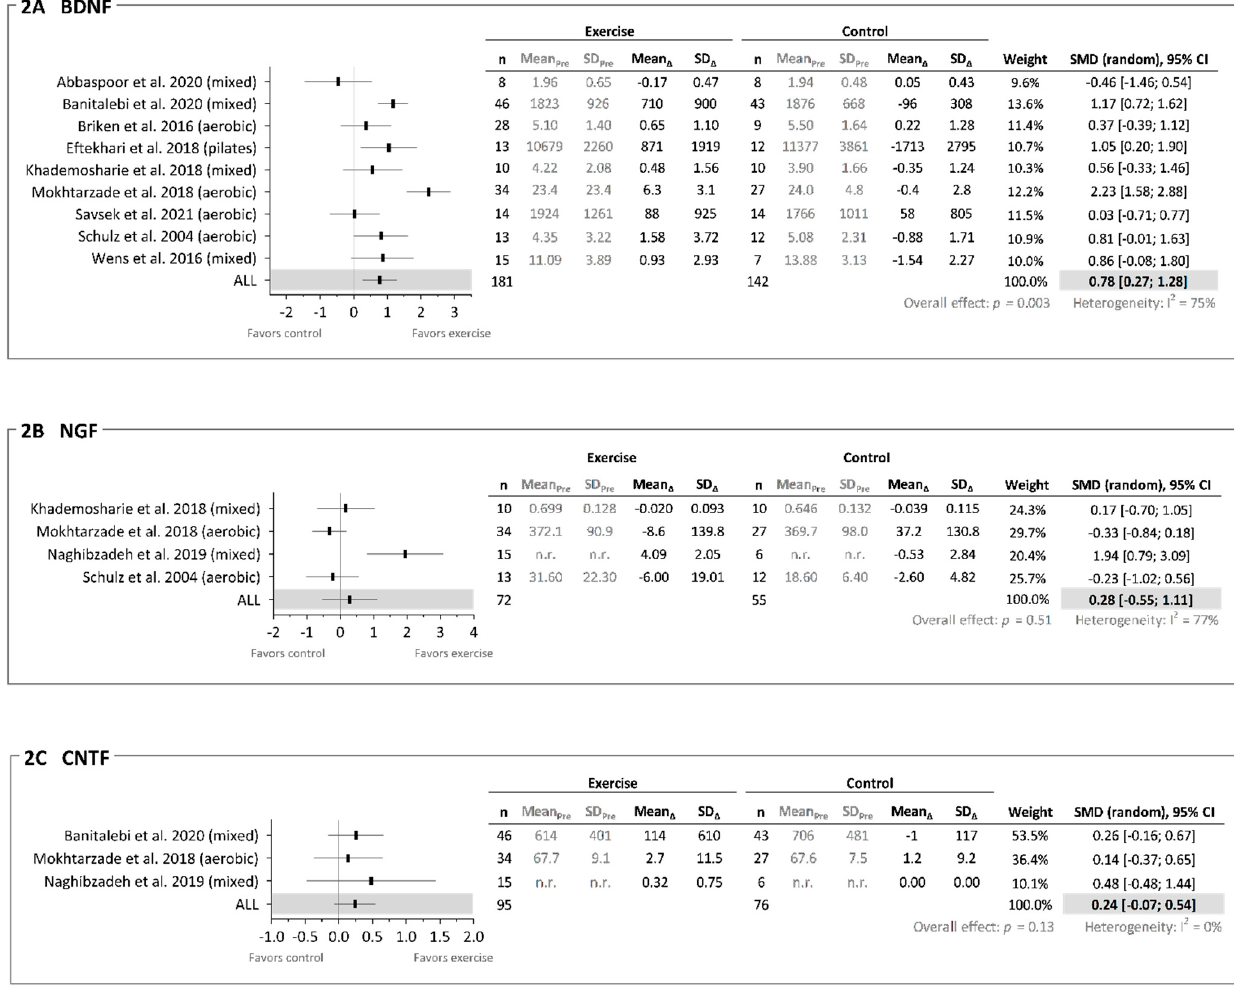
Figure 2. Meta-analysis of the effects of exercise on chronic levels of neurotrophic factors. ( A ): Chronic levels of BDNF (brain-derived neurotrophic factor). ( B ): Chronic levels of NGF (nerve growth factor). ( C ): Chronic levels of CNTF (ciliary neurotrophic factor). Units of neurotrophic factors are displayed as ng·mL − 1 . See Table 1 and 2 for further study details.